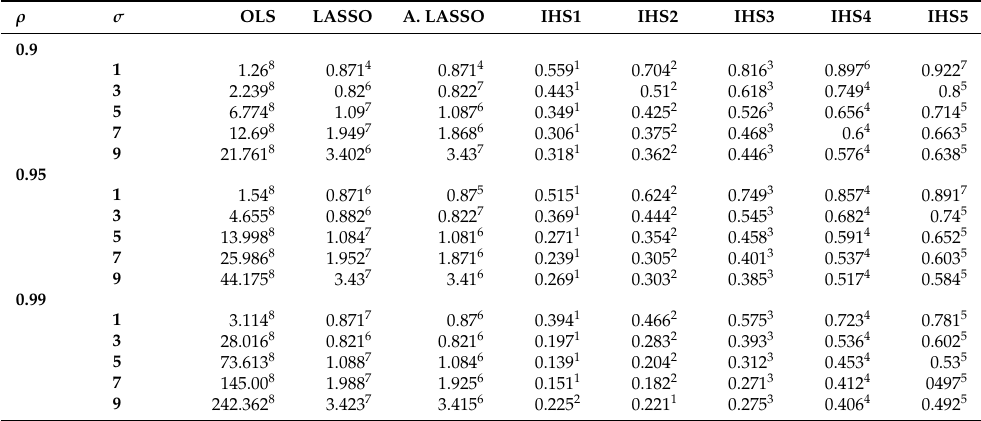
Table 2. Estimated MSEs for n = 100 and p = 4 (superscript represents ranking).